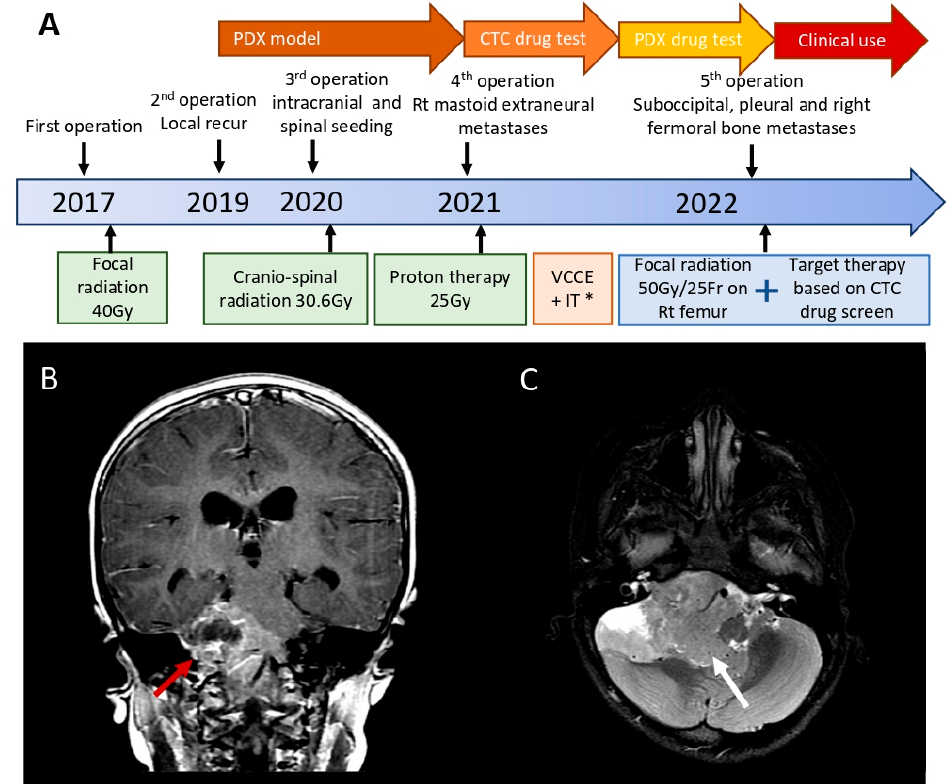
Figure 1. Primary ependymoma on the right cerebello-pontine angle with brain stem compression and extraneural metastasis in a 6-year-old girl. ( A ) Timeline of disease course and recurrence. * VCCE: vincristine, cisplatin, cyclophosphamide, etoposide; IT: intrathecal chemotherapy. ( B ) T1-weighted MR image with contrast enhancement showing the initial tumor mass wrapping the lower cranial nerve on the right cerebello-pontine angle (red arrow). ( C ) Axial view of the diffusion-weight image showing the iso-dense tumor mass compressing the brain stem (white arrow).